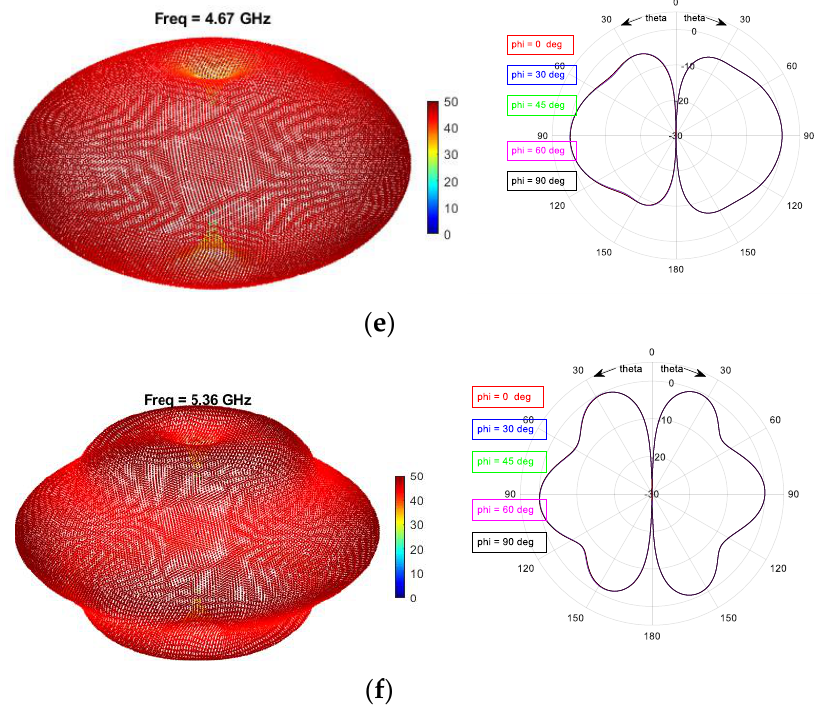
Figure 10. 3D patterns of the base MBA obtained by our FD-TD solver (left column) and 2D patterns (right column) at different phi-cutting planes (shown by different colors) at the beginning, middle and end frequency points of two lower bands with VSWR ≤ 2. In all 2D plots, our FD-TD and GEMS results are plotted on the right and left sides, respectively. Subplots ( a – f ) are far field patterns at 0.93 GHz, 1.08 GHz, 1.23 GHz, 3.97 GHz, 4.67 GHz and 5.36 GHz, respectively.